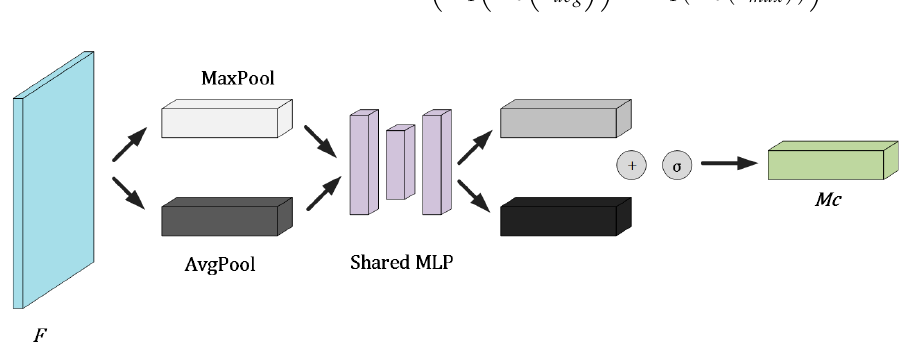
Figure 5. Channel attention module.